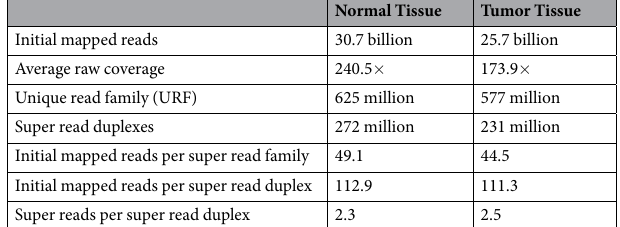
Table 1. Data yield from DEEPER-Seq WES sequencing. Data yield from DEEPER-Seq WES sequencing. Initial mapped reads represent raw reads that contain the 12nt barcode and mapped to the reference genome. Unique read family represents the number of URF. Each URF has a unique barcode and its sequence is obtained by consolidating read sequences arise from the same DNA molecule by PCR amplification. PCR errors are removed by requesting a sequence uniformity for over 95% of the reads within a URF. Super read duplexes represent the number of DNA duplex whose two strands are coming from two super